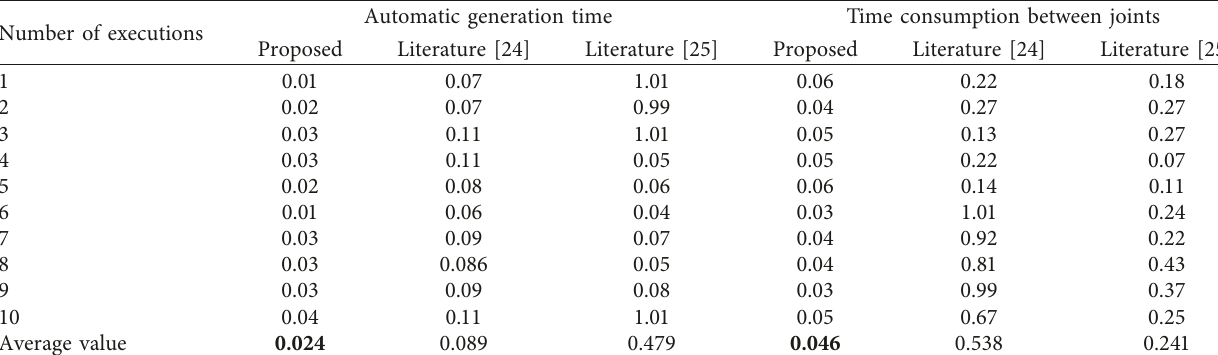
Table 3: Comparison of maximum time